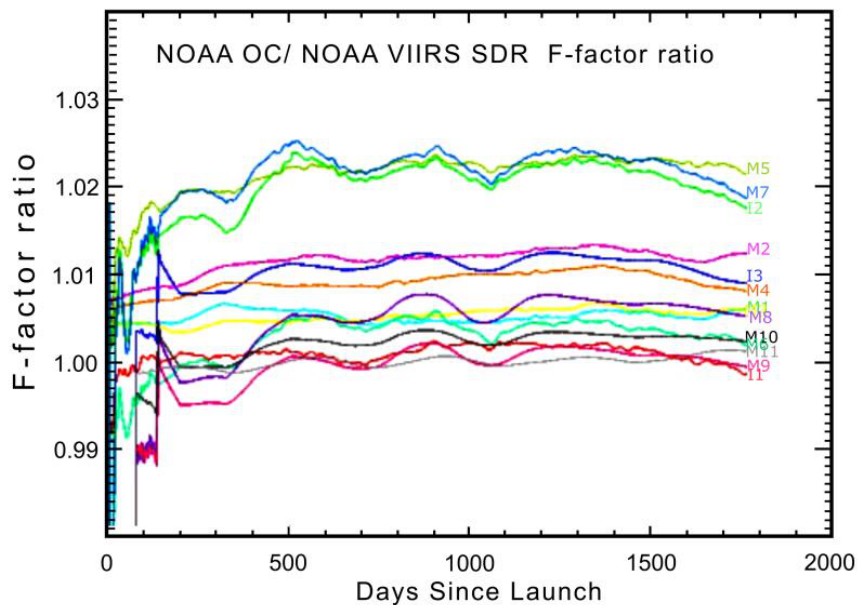
Figure 13. Differences between SD F-factors with Kalman filter correction (V2) and OC SD F-factors. The calibration differences for M1-4 are within 2% level, nearly mitigated after the correction.